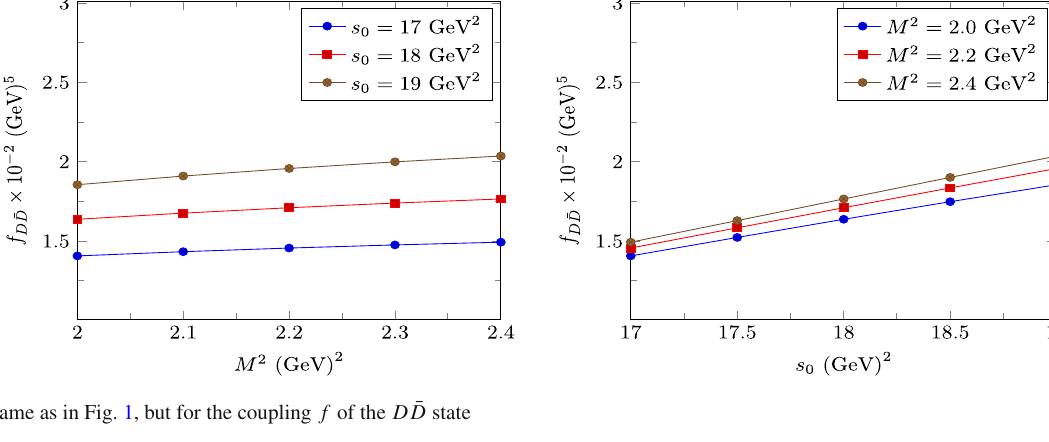
In Figs. 1, 2, 3 and 4 we plot the mass and decay constant ¯ D and D + D − of D states as functions of M 2 and s 0 , respec- s s